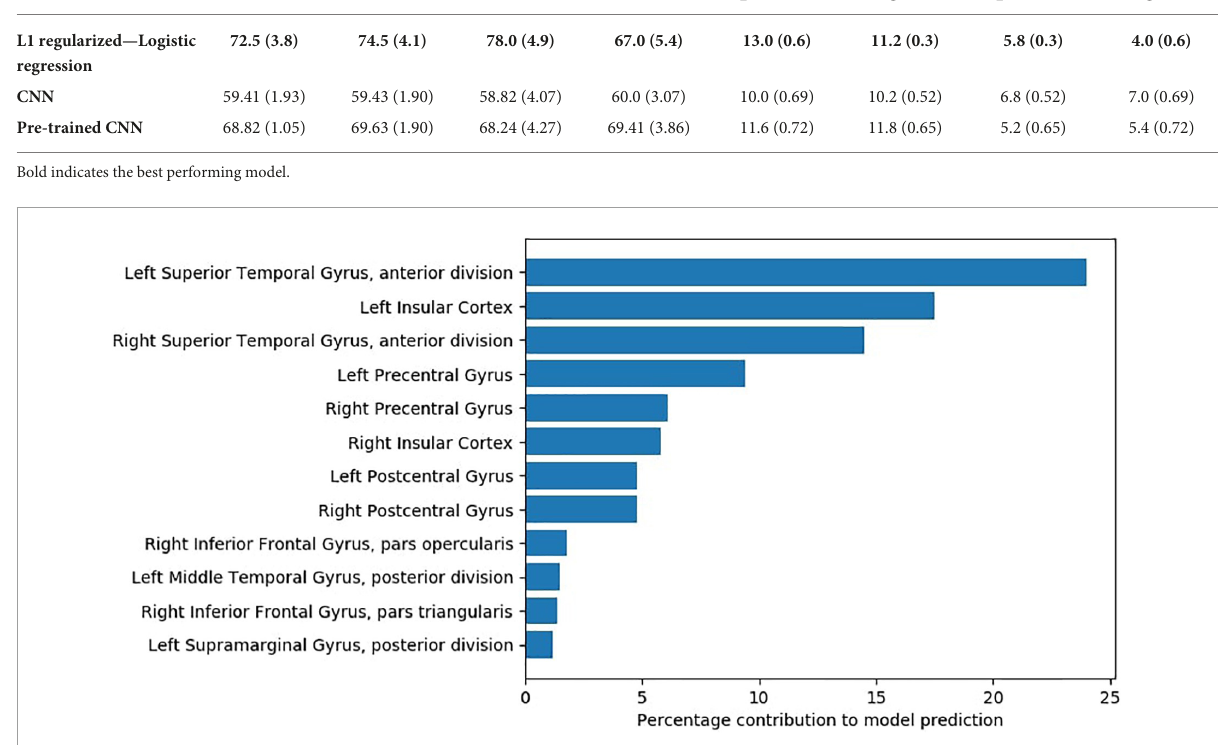
FIGURE3 Percentage contributions of brain regions based on voxels with top 1000 SHAP values.